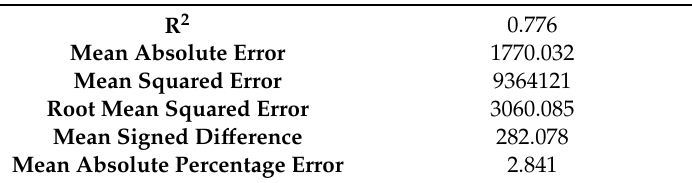
Table 7. The validation set diagnostics.